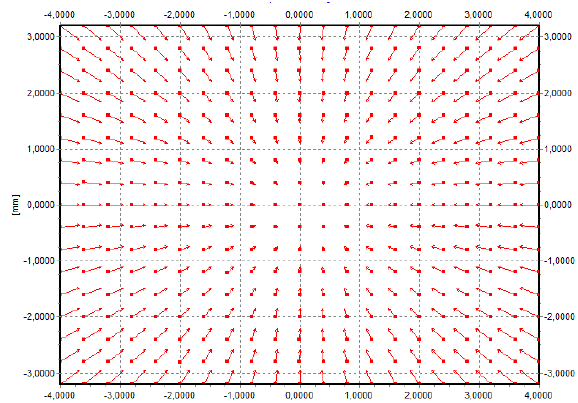
Figure 10: Eccentricity in projection of a spherical target with r =10mm